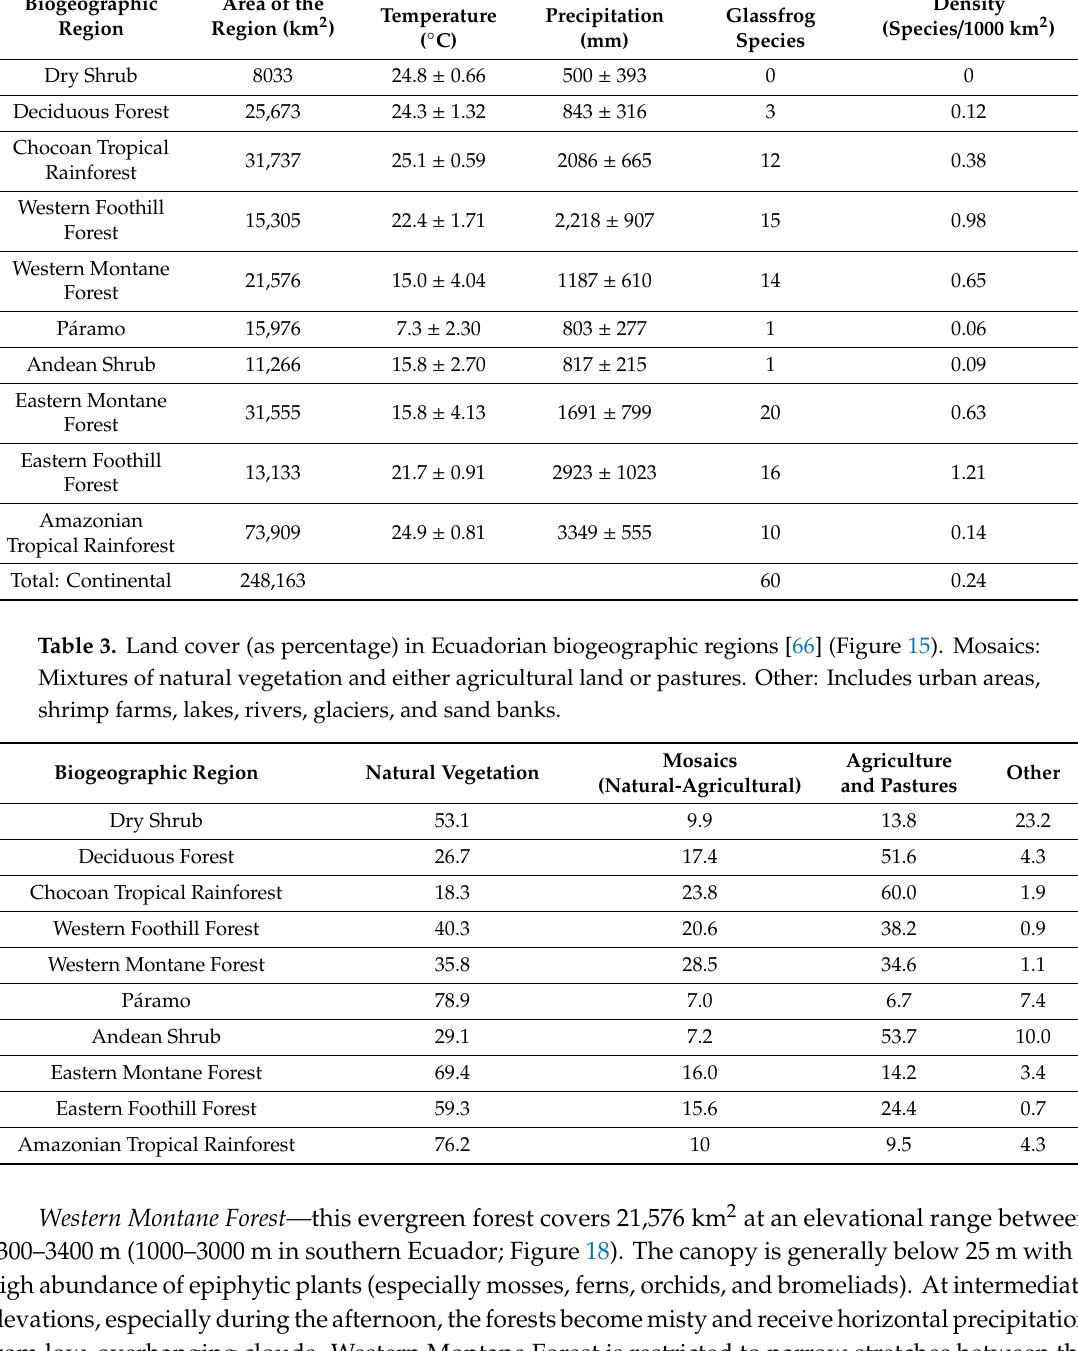
Table 2. Glassfrog diversity and climate in the Ecuadorian biogeographic regions, as defined in Figure 14 [65,66]. Note that any given species can occur in more than one biogeographic region. Biogeographic Region